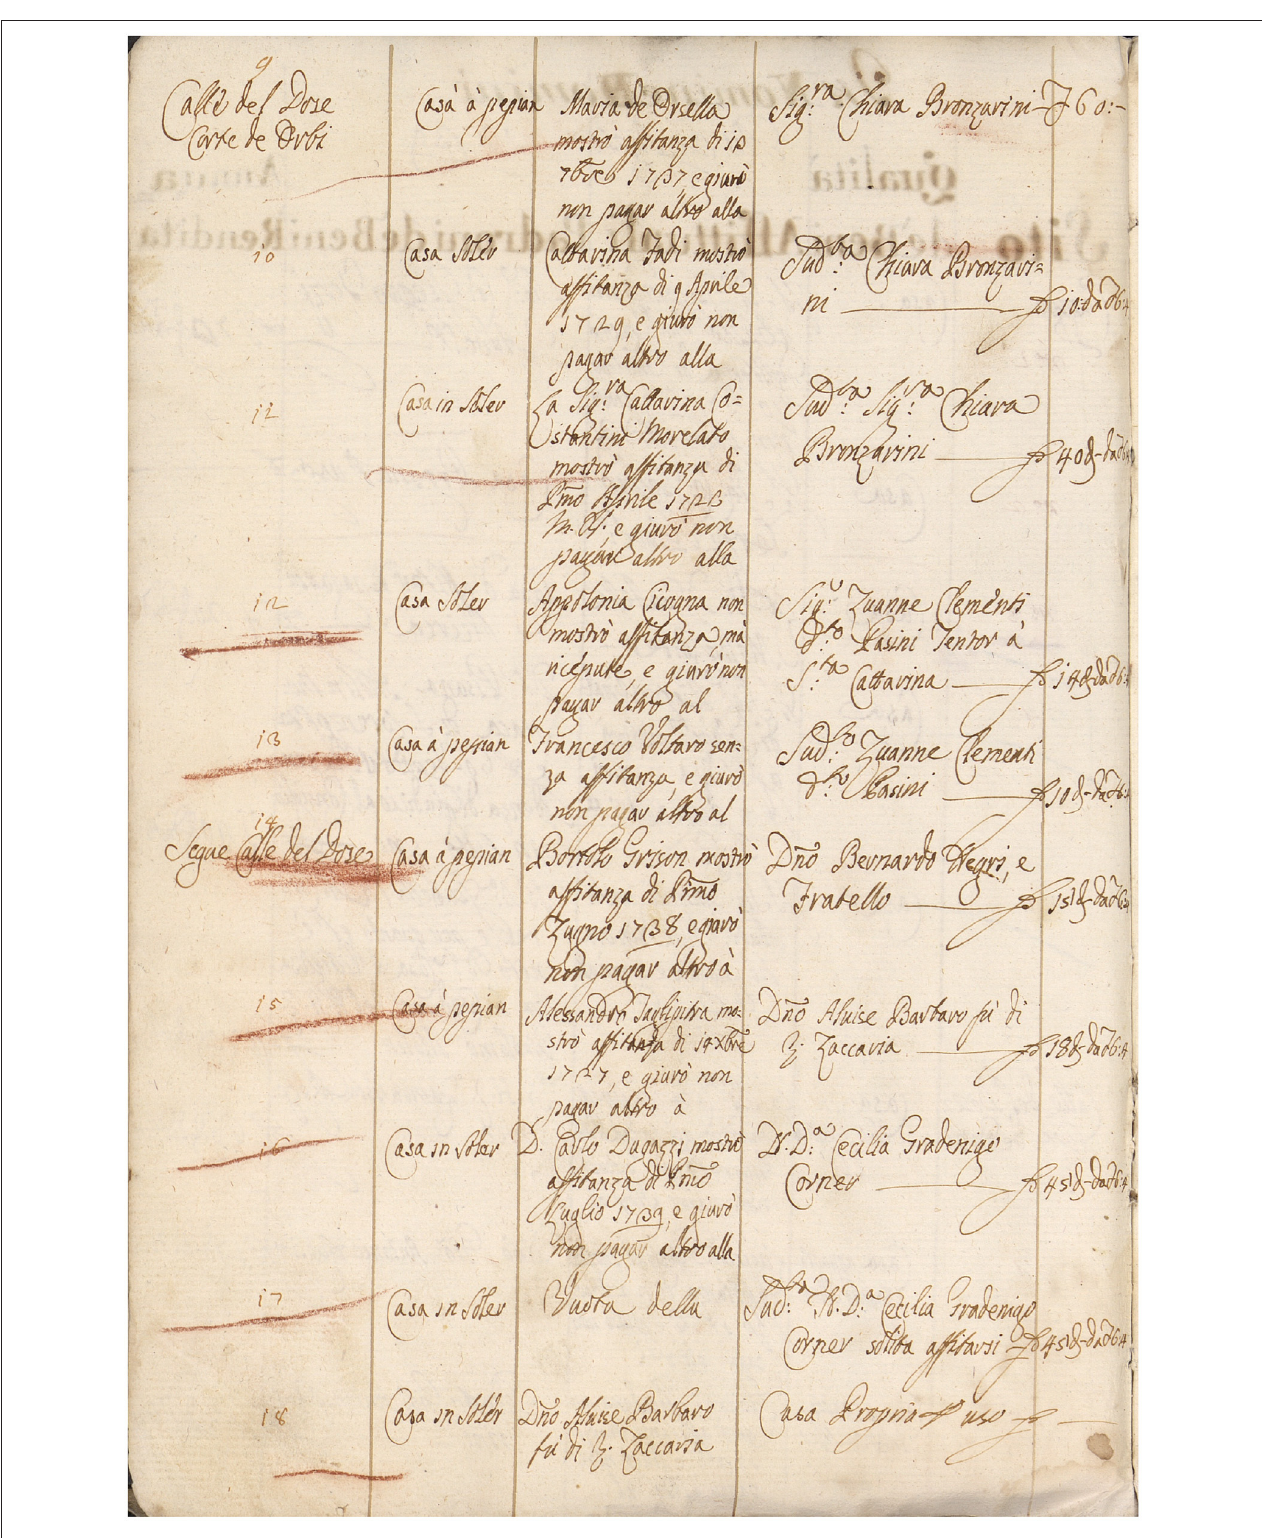
FIGURE 6 | A set of entries in a register of the Catastici . Entry 15 (leftmost column, in red) refers to one of the houses owned by “Alvise Barbaro,” who is mentioned as landlord in column 4: “Domino Alvise Barbaro fu di Ser Zaccaria.” From: State Archive of Venice, X Savi alle decime in Rialto , Catastici delle parrocchie , 1740, San Maurizio , f. 434, c.